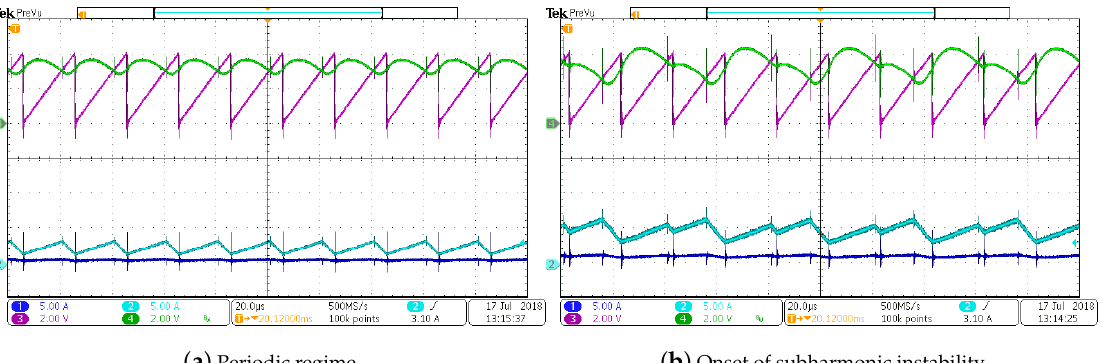
= 138 µ H and L ∗ = 5.5 mH (dashed curve), by updating the 2 1 ) and experimentally ( (cid:63) ). (cid:52)